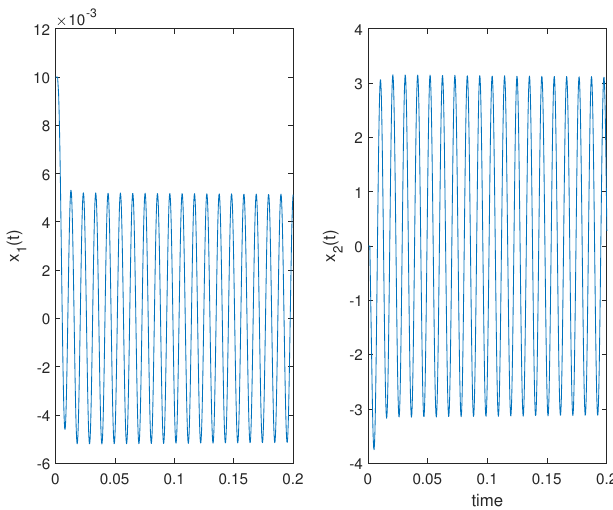
Figure 4. State trajectories of the state vector X ( t ) of Case 2.